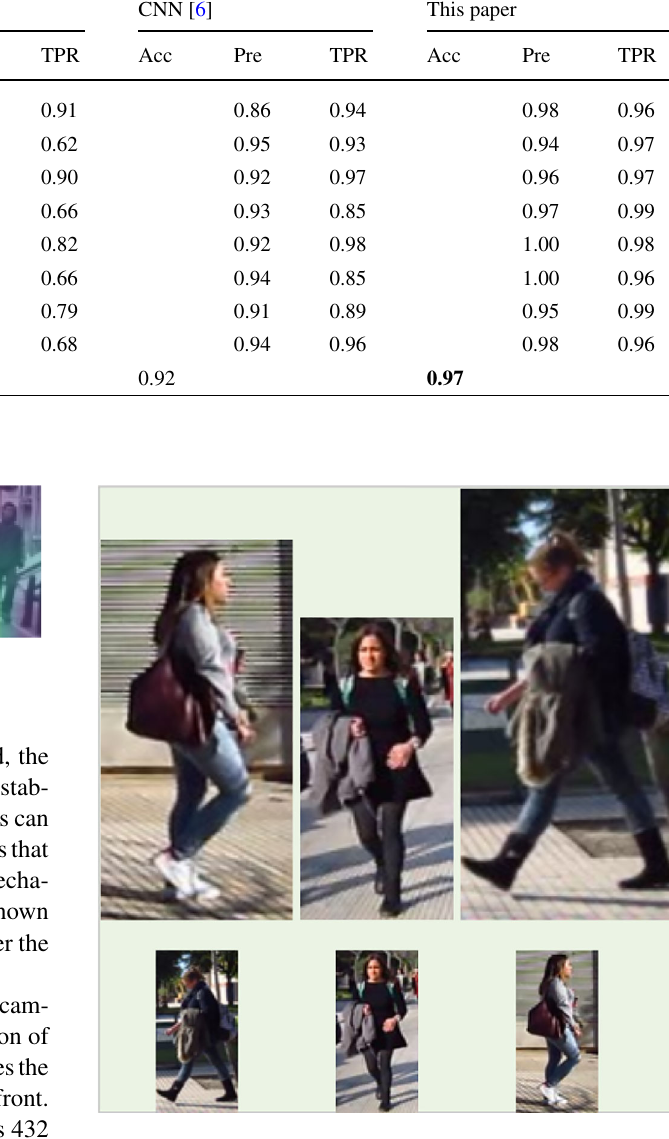
Fig. 14 PDRD preprocessing. 1st row: original image. 2nd row: resized image